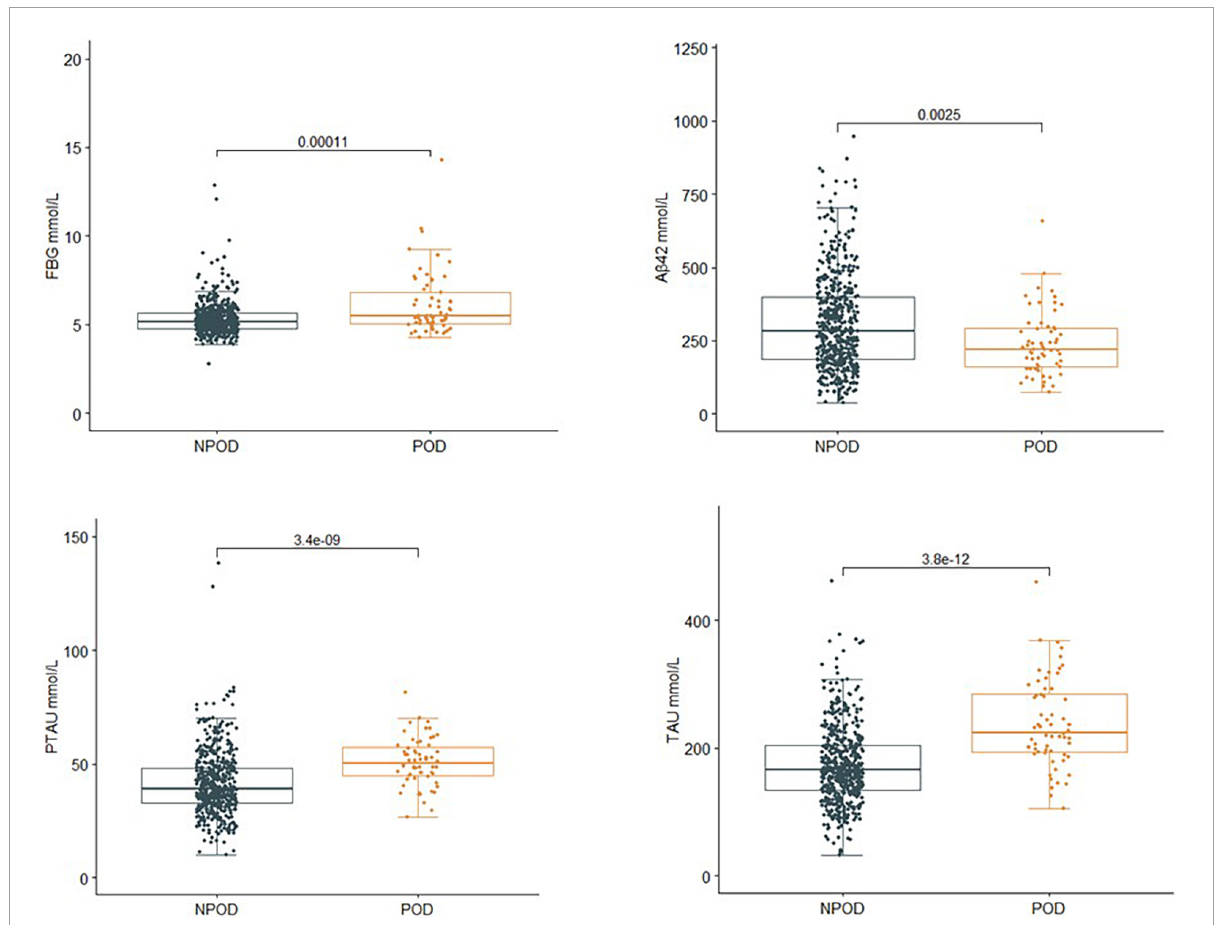
FIGURE2 Comparison of FBG and CSF biomarker levels between two groups. Compared with the non-POD group, the differences in FBG ( P < 0.001), CSF levels of P-tau ( P < 0.001), and T-tau ( P < 0.001) of the POD group were statistically significant ( P < 0.05). POD, postoperative delirium; NPOD, no postoperative delirium; FBG, fasting blood glucose; A β 42, β -amyloid42; T-tau, total tau; P-tau, phosphorylated